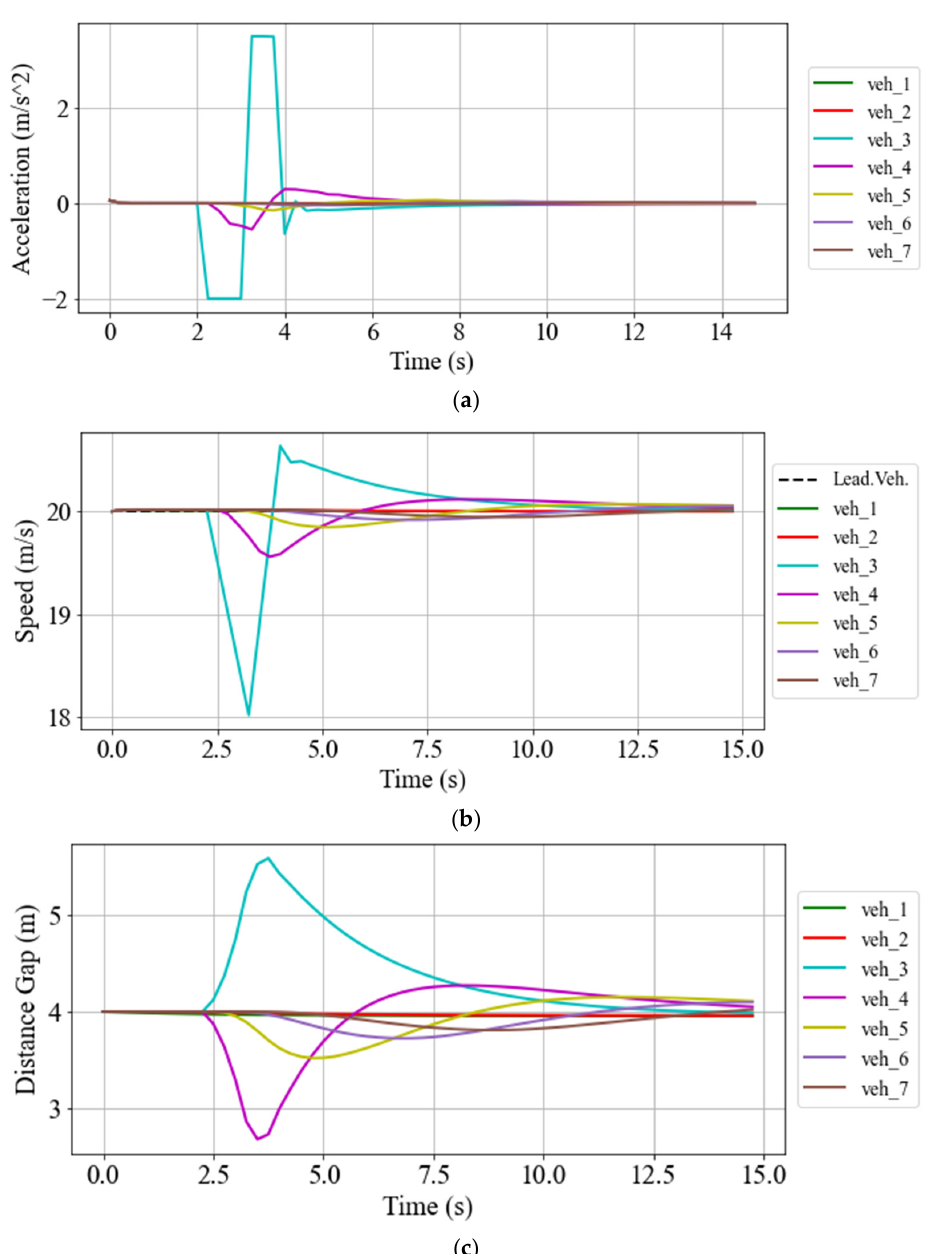
Figure 7. Acceleration ( a ), speed ( b ), and distance-gap ( c ) variations in platoon vehicles relative to the drastic braking of the third vehicle.